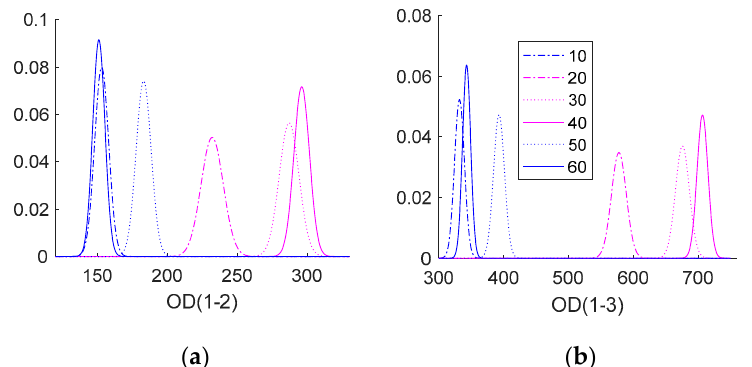
Figure 3. Probability distribution of Bayesian learning-based OD demands under different time intervals. ( a ) OD pair 1-2. ( b ) OD pair 1-3.